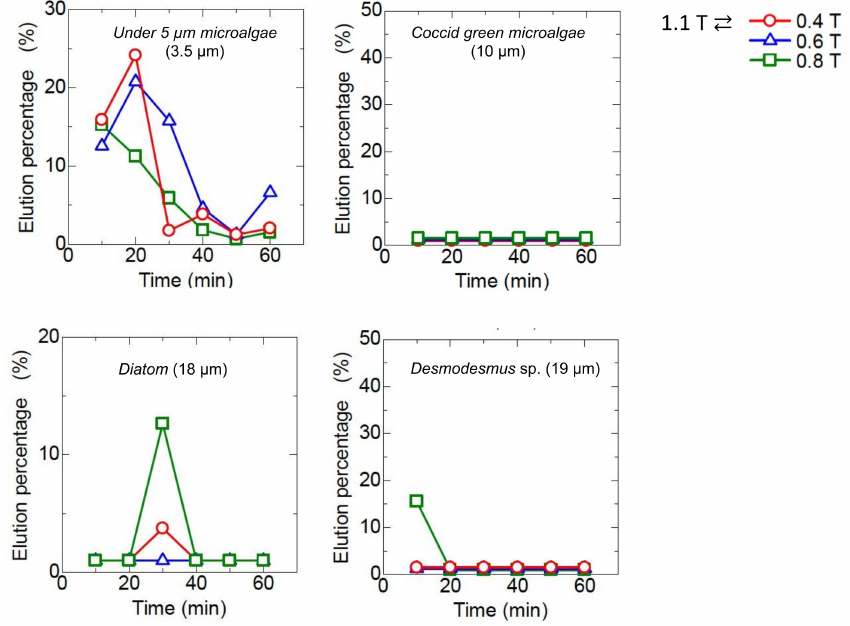
Figure 9. Dynamic elution of microalgae by a concave-like applied magnetic field. The magnetic field in the dynamic convex manner was changed at each interval of 10 min.